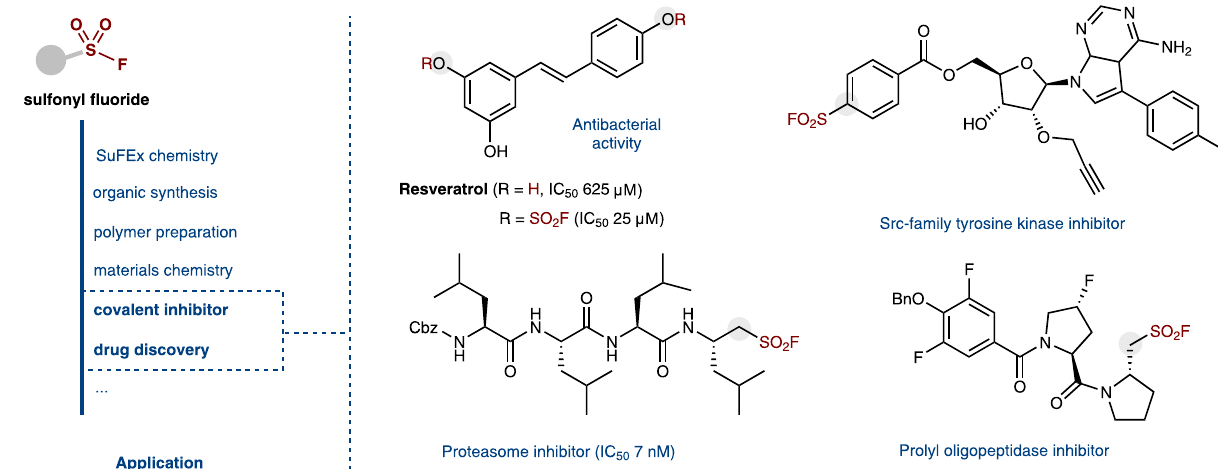
Fig. 1 Applications of sulfonyl fl uorides. Examples of biologically active molecules containing a SO 2 F